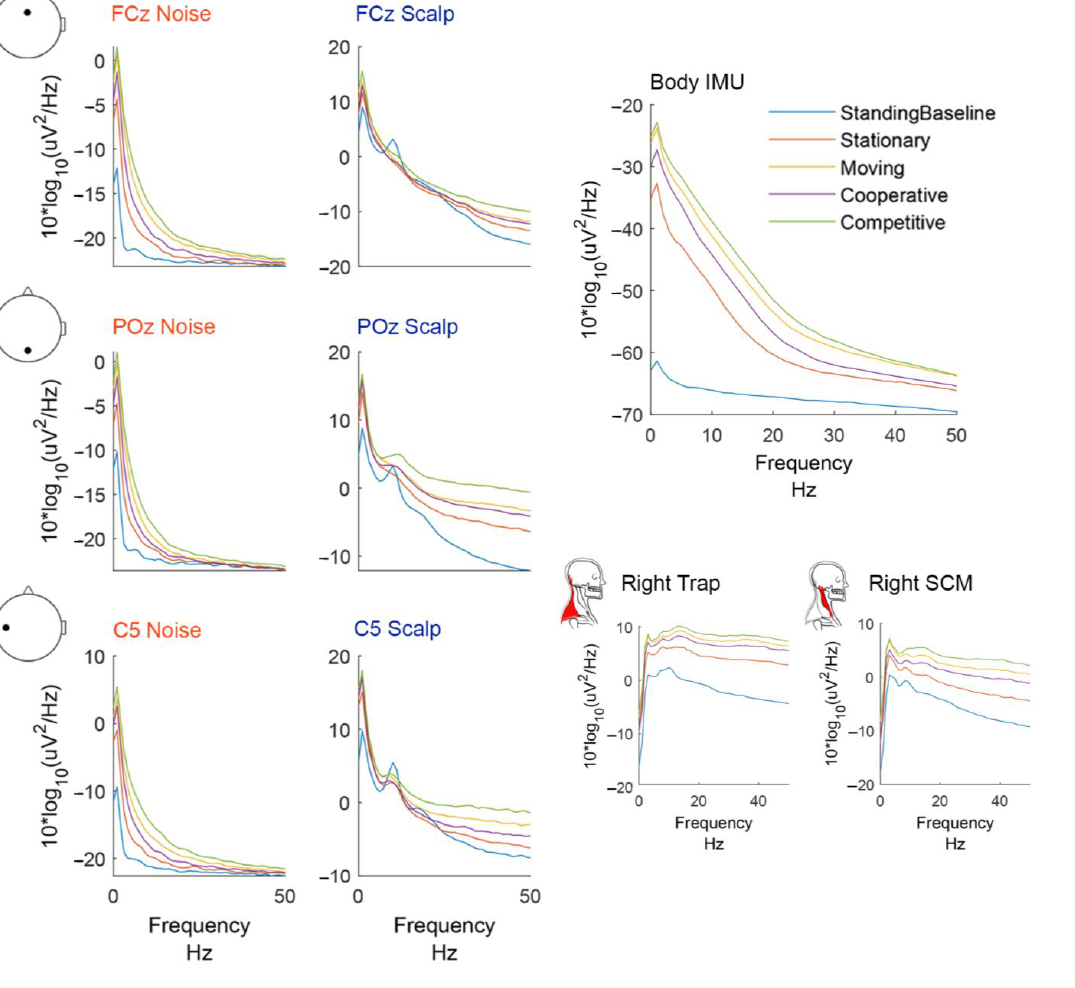
Figure 4. Group average ( n = 20) power spectral density plots. Power spectral densities were computed using the EEGLAB spectopo function (pwelch, non-overlapping hamming windows, 250 window length) on epoched data − 1 to 1 s around the participant hit events. Each condition is plotted in a different color. The mobile hitting conditions (i.e., hitting and competitive) had more power in higher frequencies than the standing baseline, stationary, and cooperative conditions. The resultant body IMU acceleration exhibited a much bigger change in low-frequency power between the standing baseline and all other hitting conditions. The body IMU had more power in frequencies 5 – 30 Hz than the noise electrodes. The bipolar neck EMG channels had low power in low frequencies and high power in high frequencies with a broadband increase in power for the mobile hitting conditions. All sensor types and hitting conditions showed statistically significant time-fre- quency pixel changes in power compared to the standing baseline condition (Figure 5).